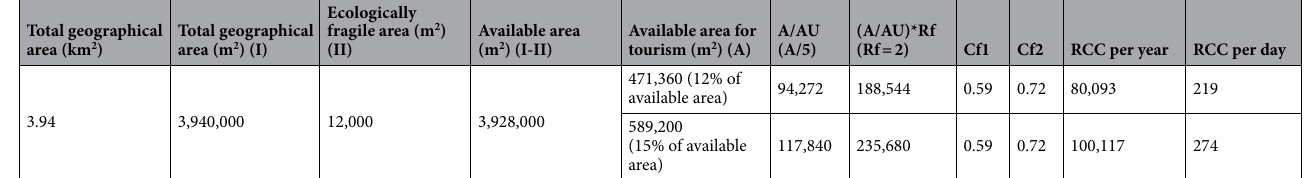
Table 2. Estimation of tourists’ carrying capacity for the Dayara Bugyal (A = Available area for tourists use, Au = Area required per tourist, Rf = Daily open period / average time of visit, Cf 1 = Correction factor 1(rainfall), Cf2 = Correction factors 2 (snowfall), RCC = Real Carrying